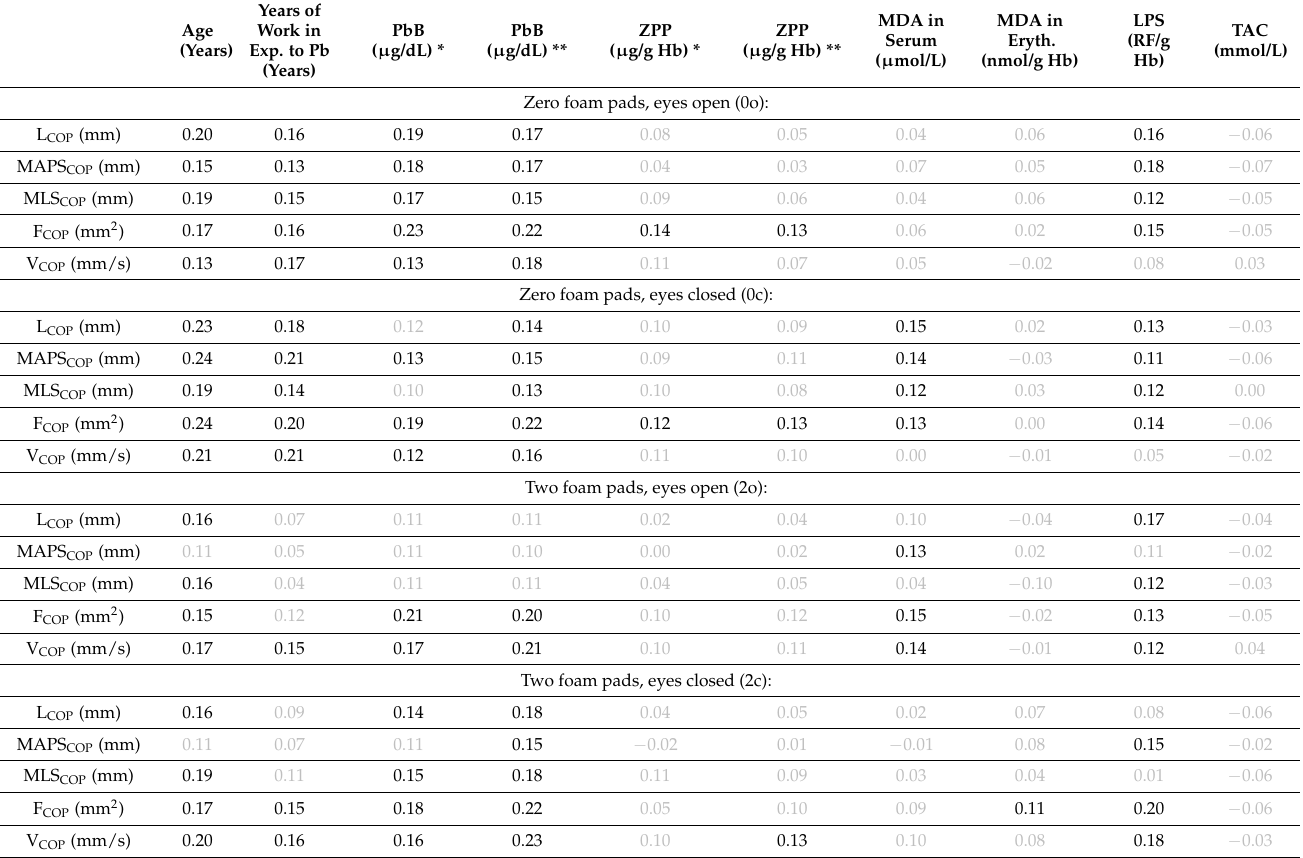
Table 4. Posturography test—Spearman’s rank order correlation, p < 0.05, marked black